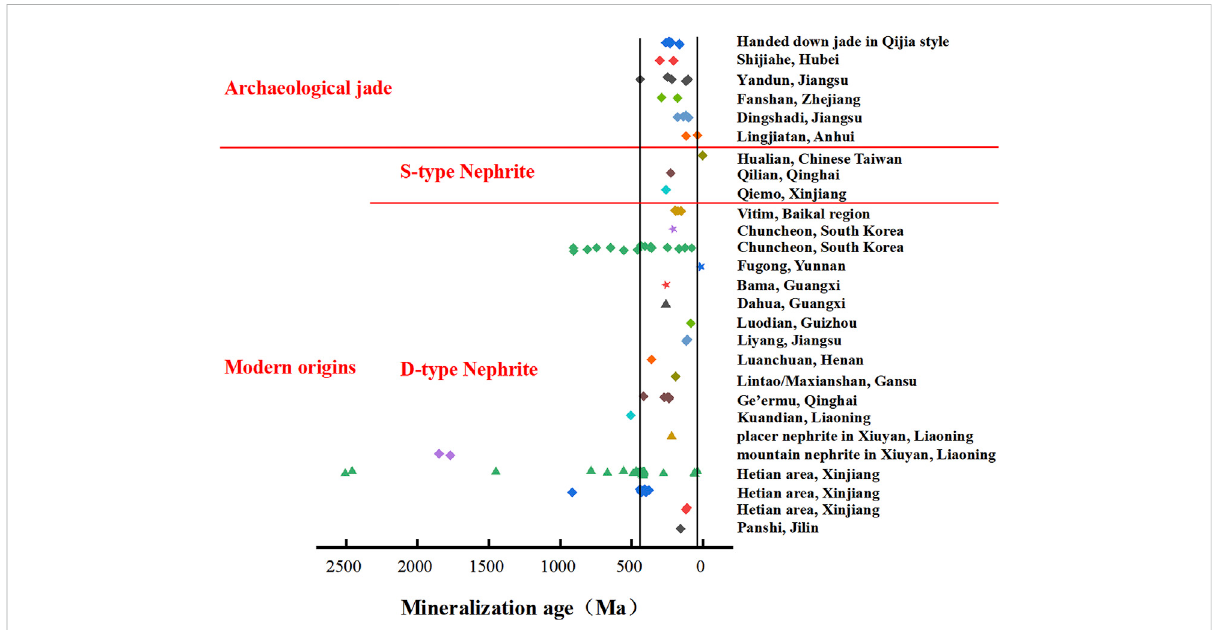
FIGURE 6 Comparative radioisotope analysis of mineralization ages of modern nephrite deposits and excavated jadewares ( ◆ means mineralization ages of nephrite; ▲ means the upper limit of mineralization ages of the nephrite; + means presumed ages of nephrite mineralization. The differences of agesiscausedbydifferenttestedsubjectanddatingmethods,whichcanbeseeninTables1,4.Therangeofblacklinesrepresentsthemineralization ages of excavated